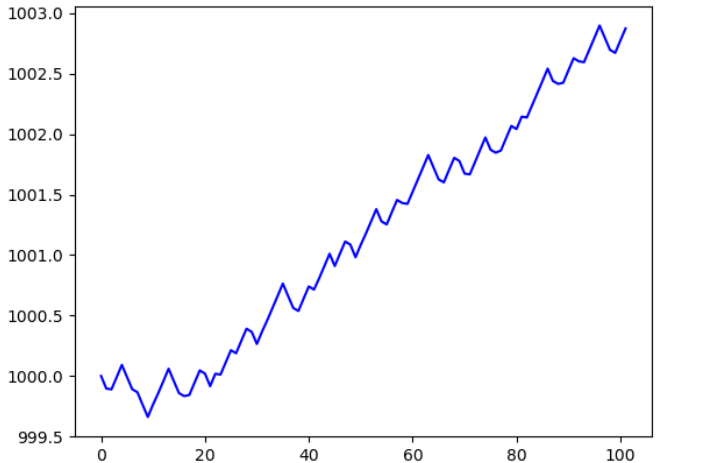
Figure A6. US500 Margin , 45 s.